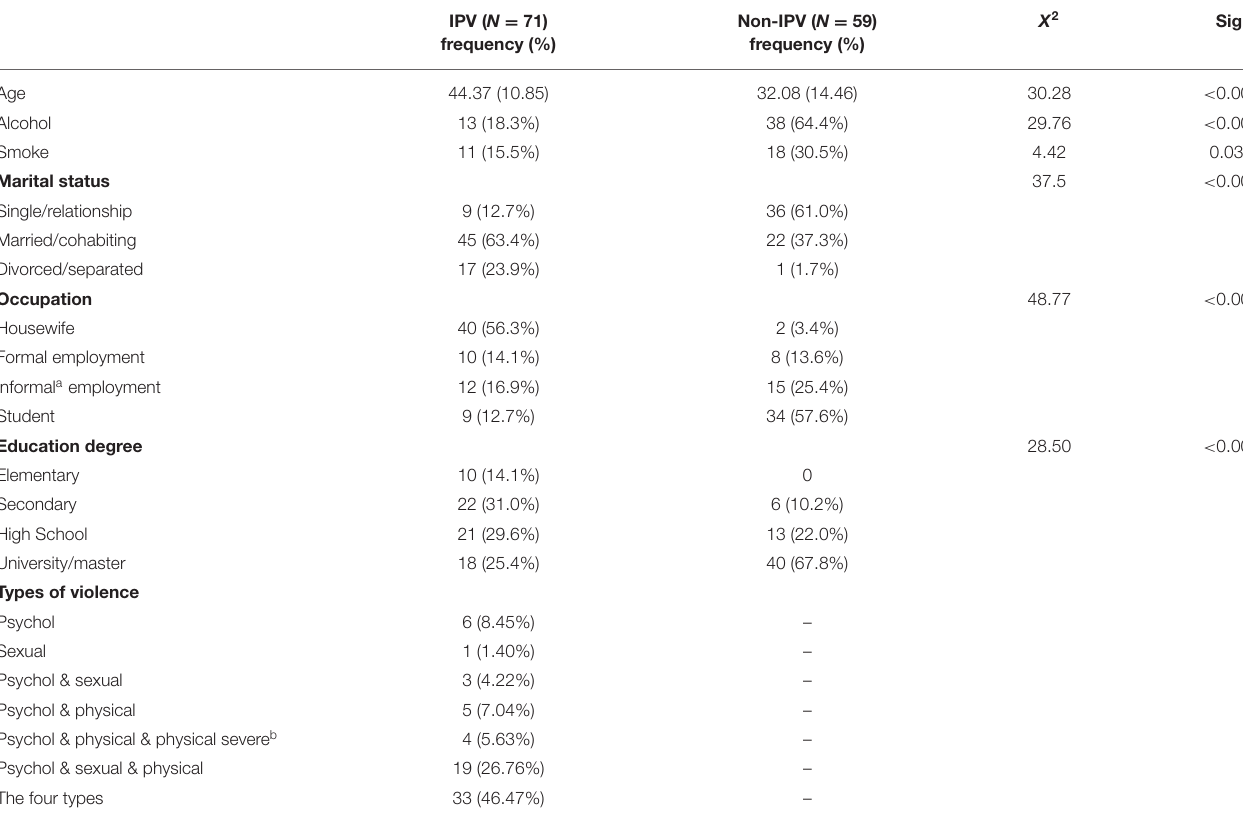
TABLE 1 | Demographic data and descriptive statists of the participants (IPV vs. control